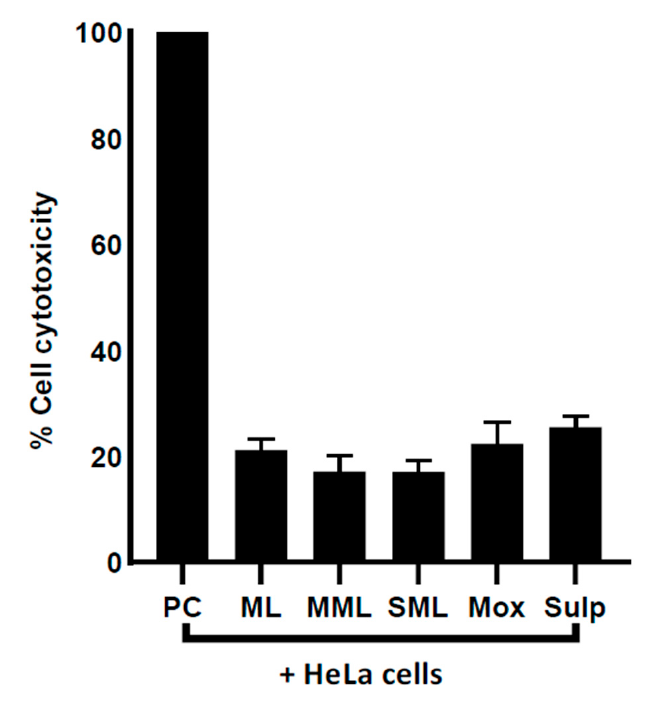
Figure 7. Drugs and drug-loaded nanocarriers demonstrated slight cytotoxic effects against HeLa cells. Human cells were grown in 96-well plate up to 80–90% confluency, as discussed in Materials and Methods. Next, cell monolayer was treated with drug–nanocarrier combinations overnight at 37 ◦ C with 5% CO 2 and 95% humidity. Where ML indicates metronidazole liposomes, MML stands for Moxifloxacin-loaded metronidazole liposomes, SML represents Sulfamethaxazole-loaded metronidazole liposomes, Mox represents Moxifloxacin, Sulp stands for Sulfamethaxazole, and PC represents positive control. The data are expressed as mean ± standard error. Data were analyzed using Graph Pad Prism software (8.0.2).